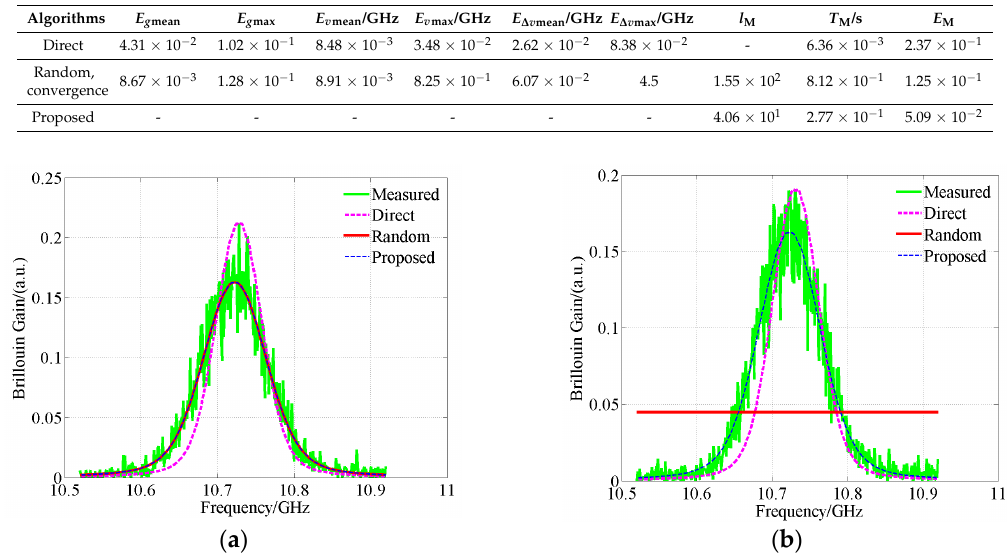
Figure 9. The measured spectra and the waveshapes fitted by three Voigt profile-based algorithms, measured signals with average number of 2 10 . ( a ) Random algorithm converges; ( b ) Random algorithm diverges.